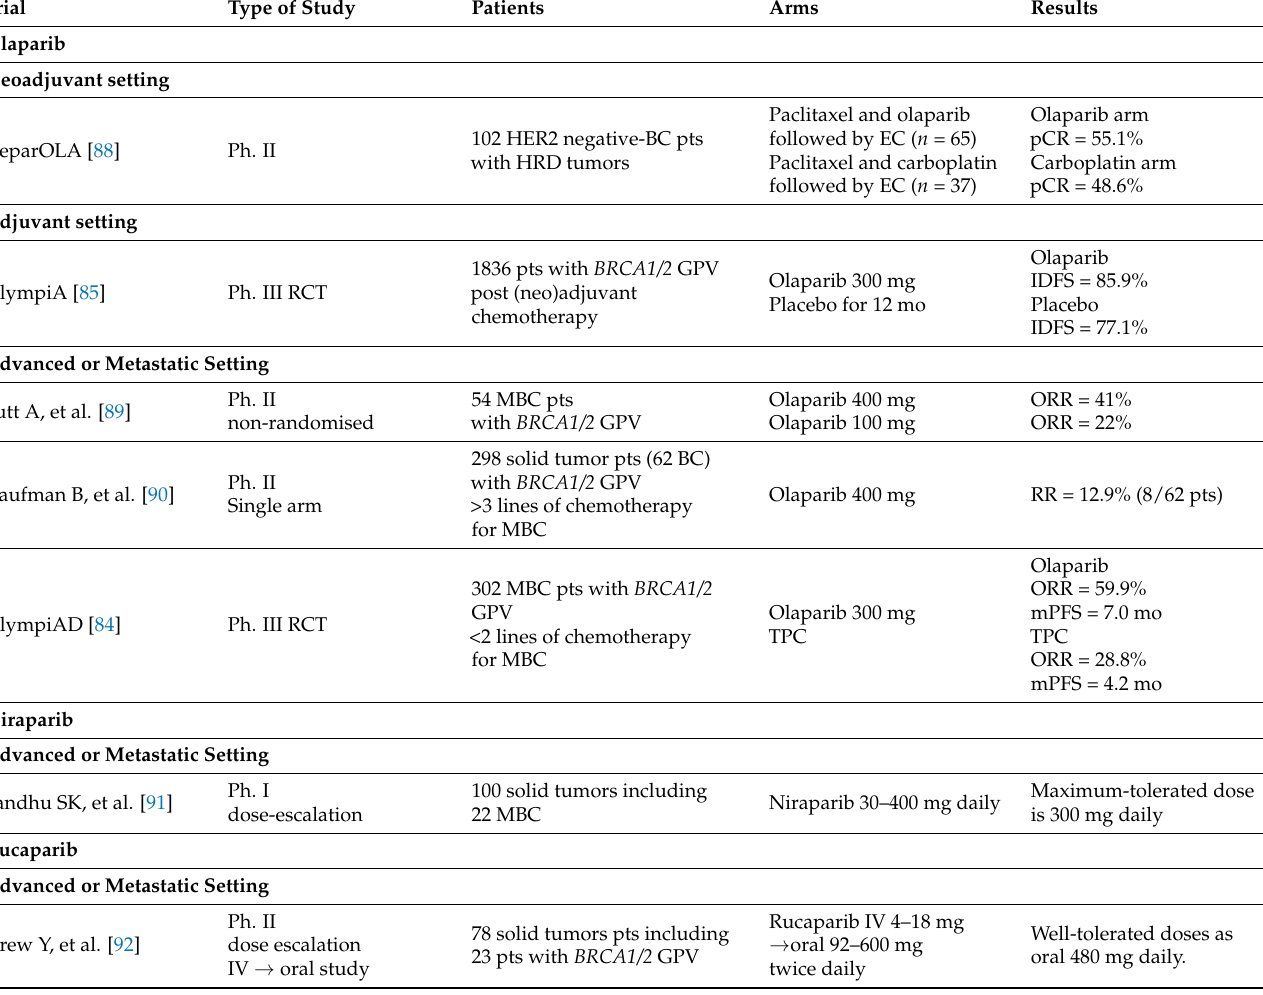
Table 3. Clinical studies of PARP inhibitors in BRCA1/2 -associated breast